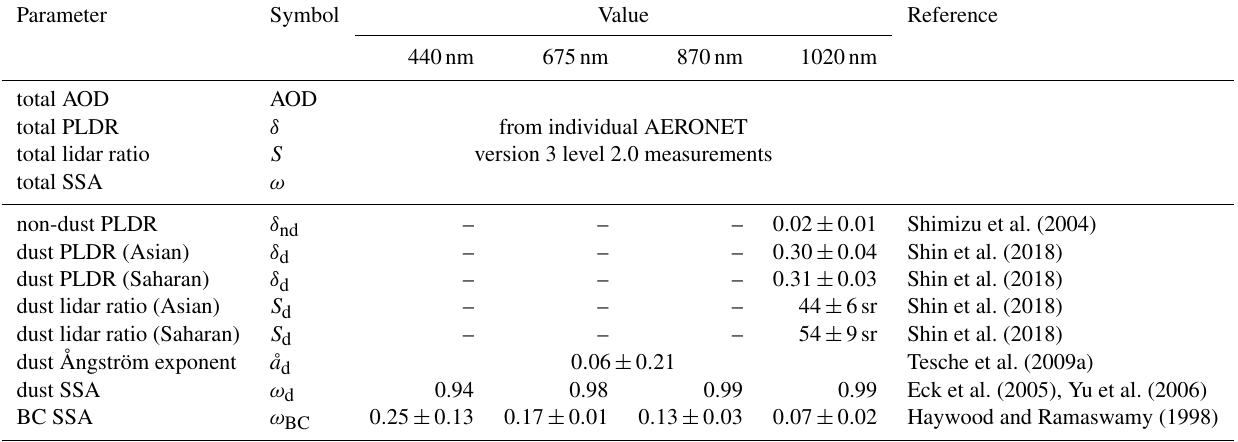
Table 1. List of input parameters used for the retrieval of AAOD nd and AAOD BC in this study. Values of δ at 1020nm are used for the separation of optical properties of dust and non-dust particles. The dust-related Ångström exponent is needed to transform findings at 1020nm to other wavelengths. The values of ω d and ω BC are used to retrieve AAOD nd and AAOD BC ,